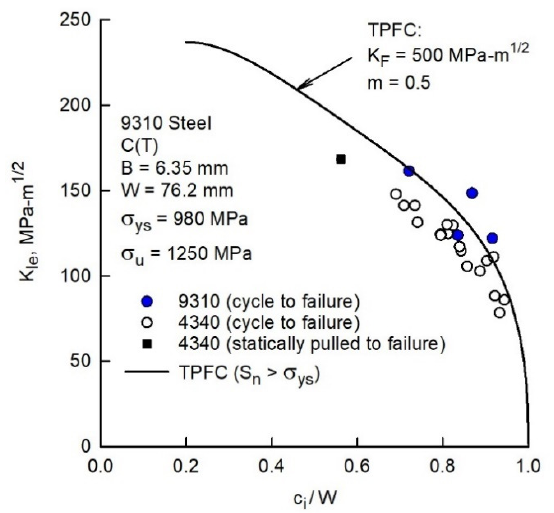
Figure 8. Elastic stress-intensity factor at failure on 9310 and 4340 steel C(T) specimens. The solid curve in Figure 8 was based on the Two-Parameter Fracture Criterion